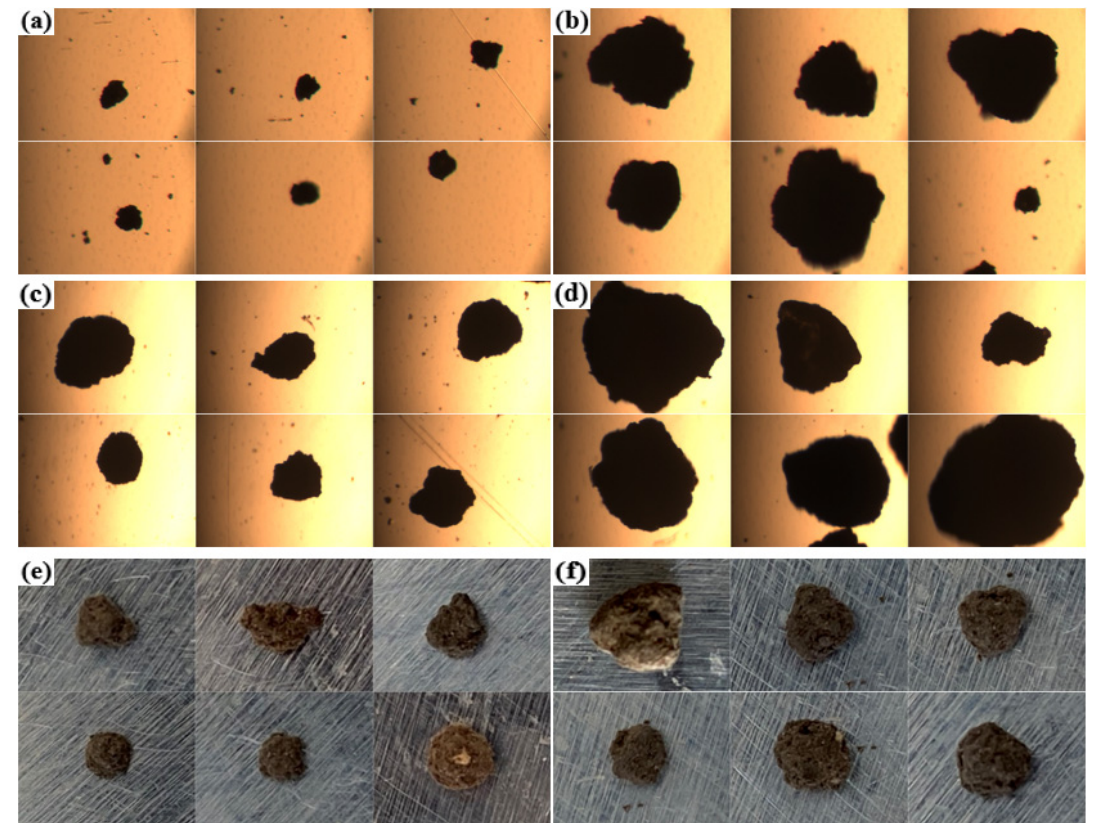
Figure 3. Enlarged view of soil particles in different size ranges: ( a ) 0~0.075 mm, ( b ) 0.075~0.25 mm, ( c ) 0.2~0.5 mm, ( d ) 0.5~1 mm, ( e ) 1~2 mm, and ( f ) 2~3 mm.